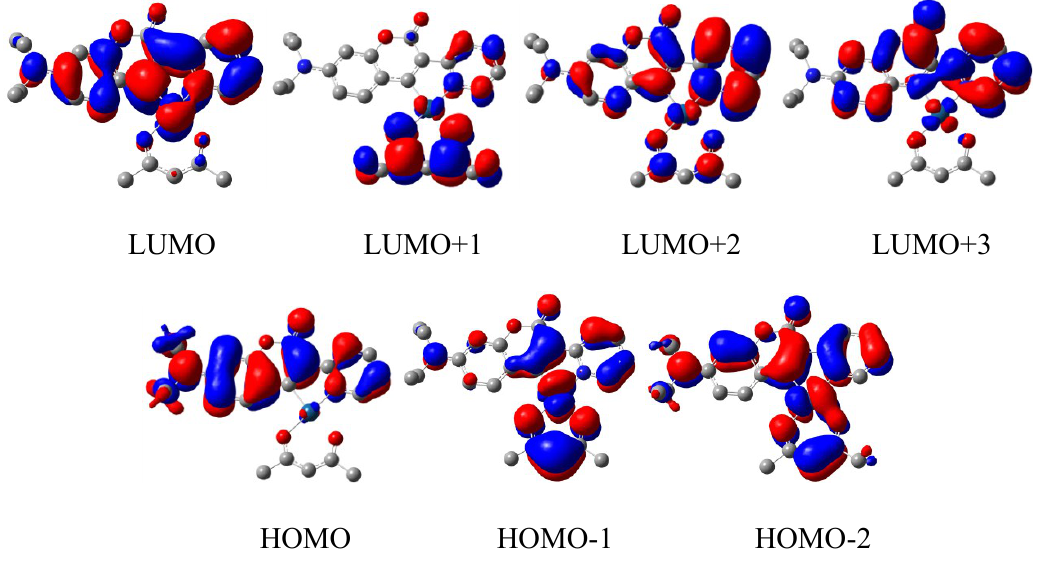
Figure 6. Selected molecular orbitals of complex 1 in the FMO